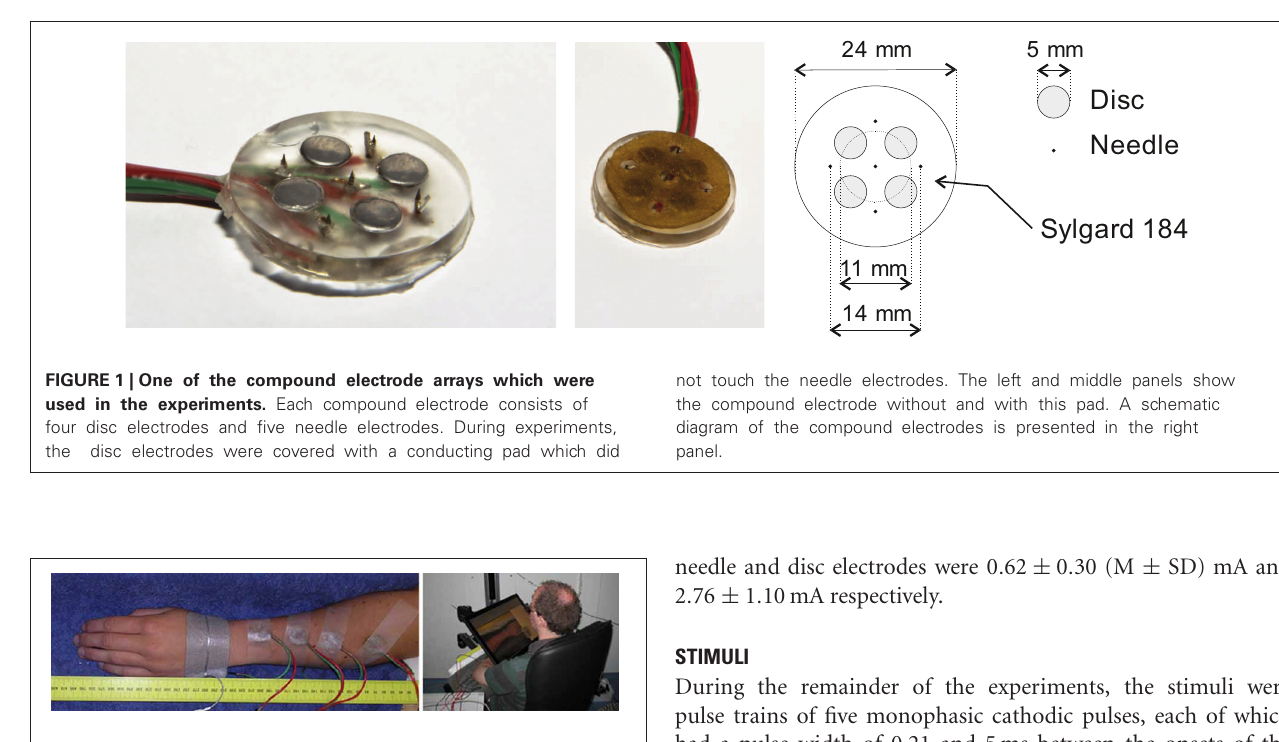
FIGURE 2 | Left: The arm of a subject with four compound electrodes (green and red wires) and a reference electrode on the hand. Right: A subject seated using the tablet screen setup. The arm with electrodes is obscured from the subject’s view by the monitor, which shows a photograph of the subject’s own arm without